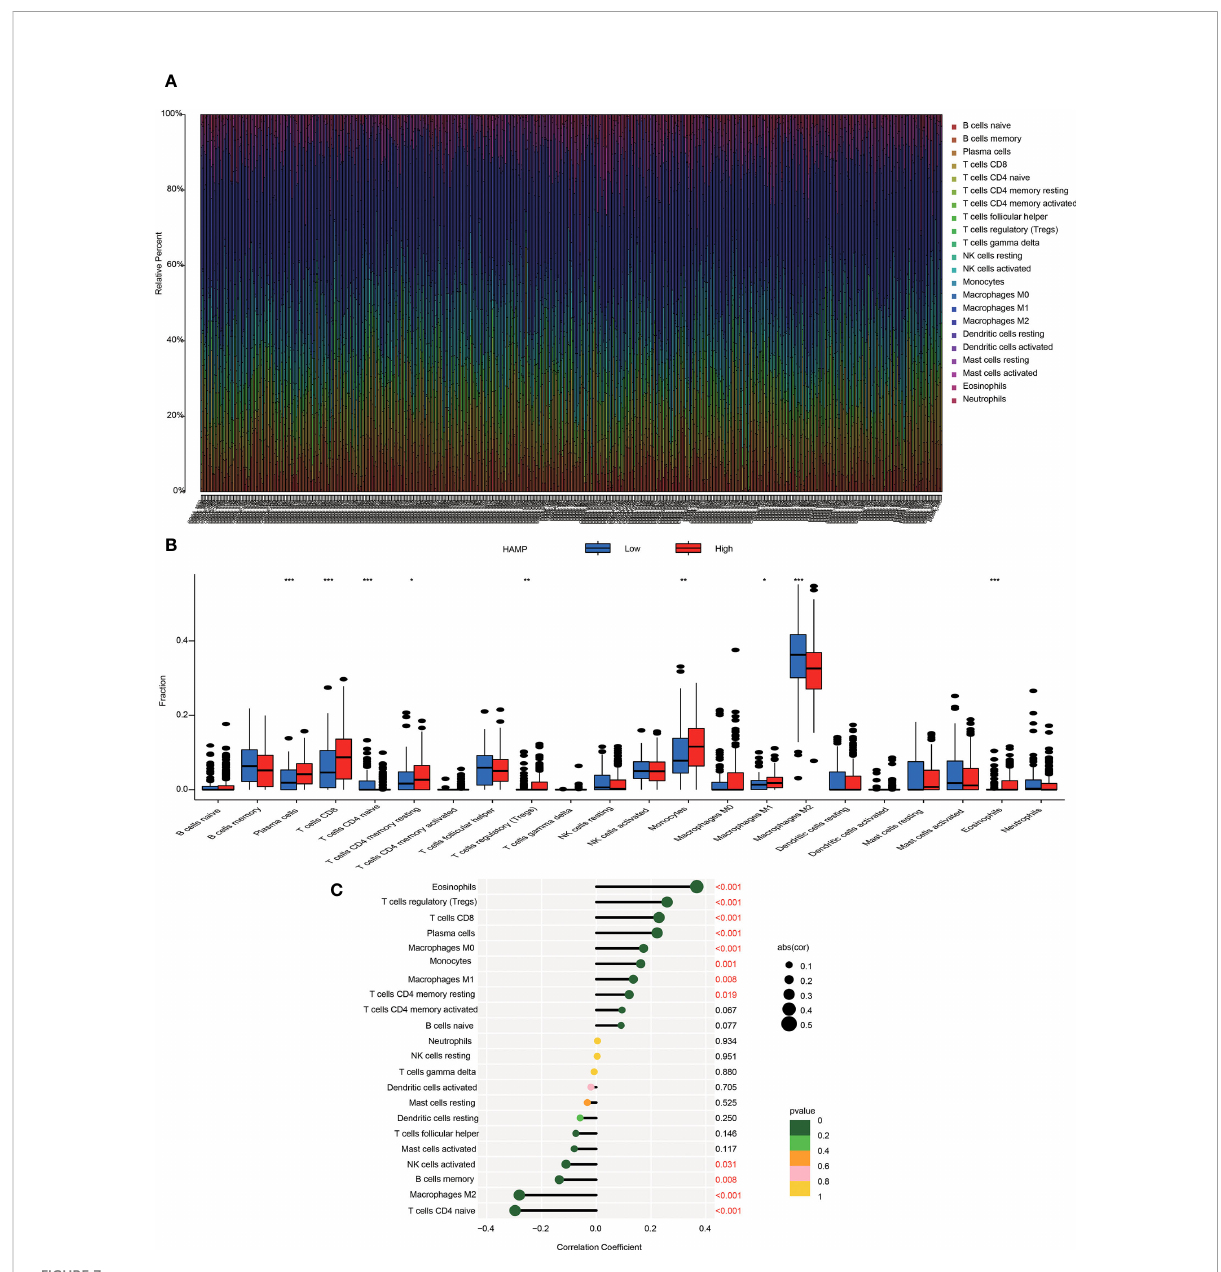
FIGURE 7 Immune cell in fi ltration with the CIBERSORT algorithm (A) The abundance ratios of immune cells in the CGGA samples. The 22 speci fi c immune cells corresponding to one sample by different colors, as shown in the bar plot. (B) The varied proportions of 22 subtypes of immune cells in the high and low hepcidin groups in tumor samples. Horizontal and vertical axes represent TIICs and relative percentages, respectively. Blue and red colors represent the low and high hepcidin expression groups, respectively. (C) The correlation between immune in fi ltrating cells and hepcidin expression. The ordinate represents the name of the immune cell, and the abscissa represents the correlation coef fi cient. * p < 0.05, ** p < 0.01, and *** p <